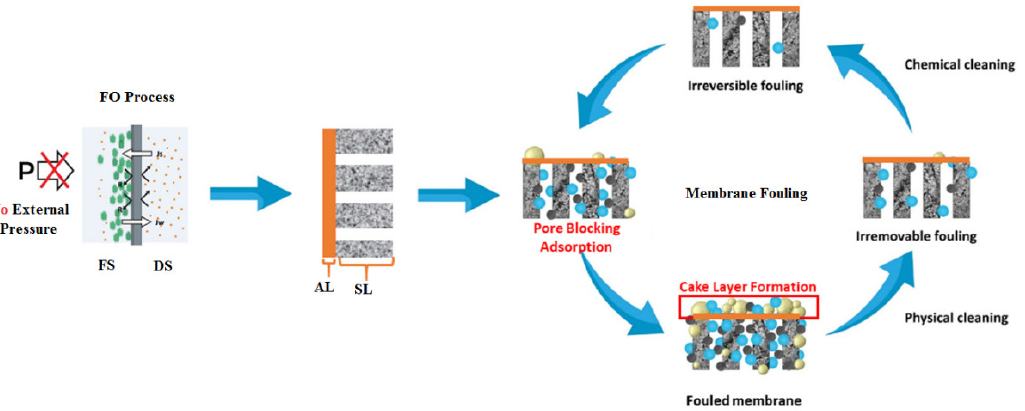
Figure 8. External and internal FO membrane fouling types [58]. FS, feed solution; DS, draw solution; AL, active layer; SL, support layer.